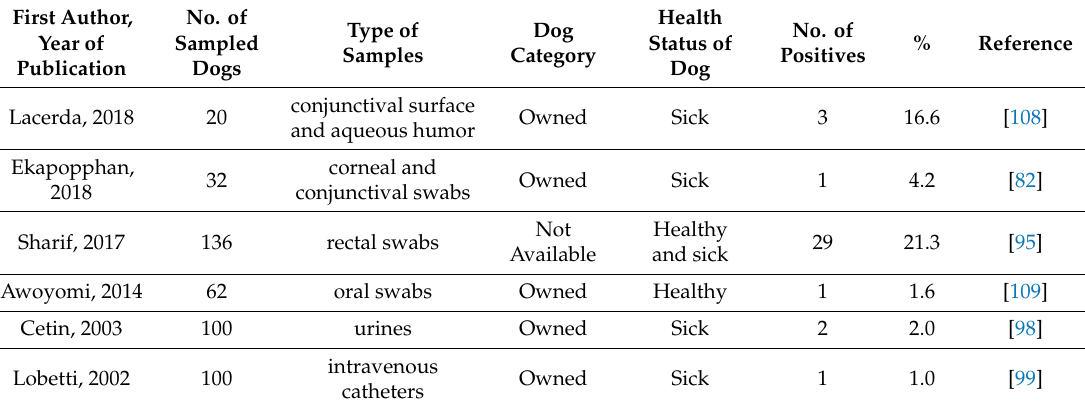
Table 7. Data of the included articles regarding the presence of Enterobacter spp. in dogs.